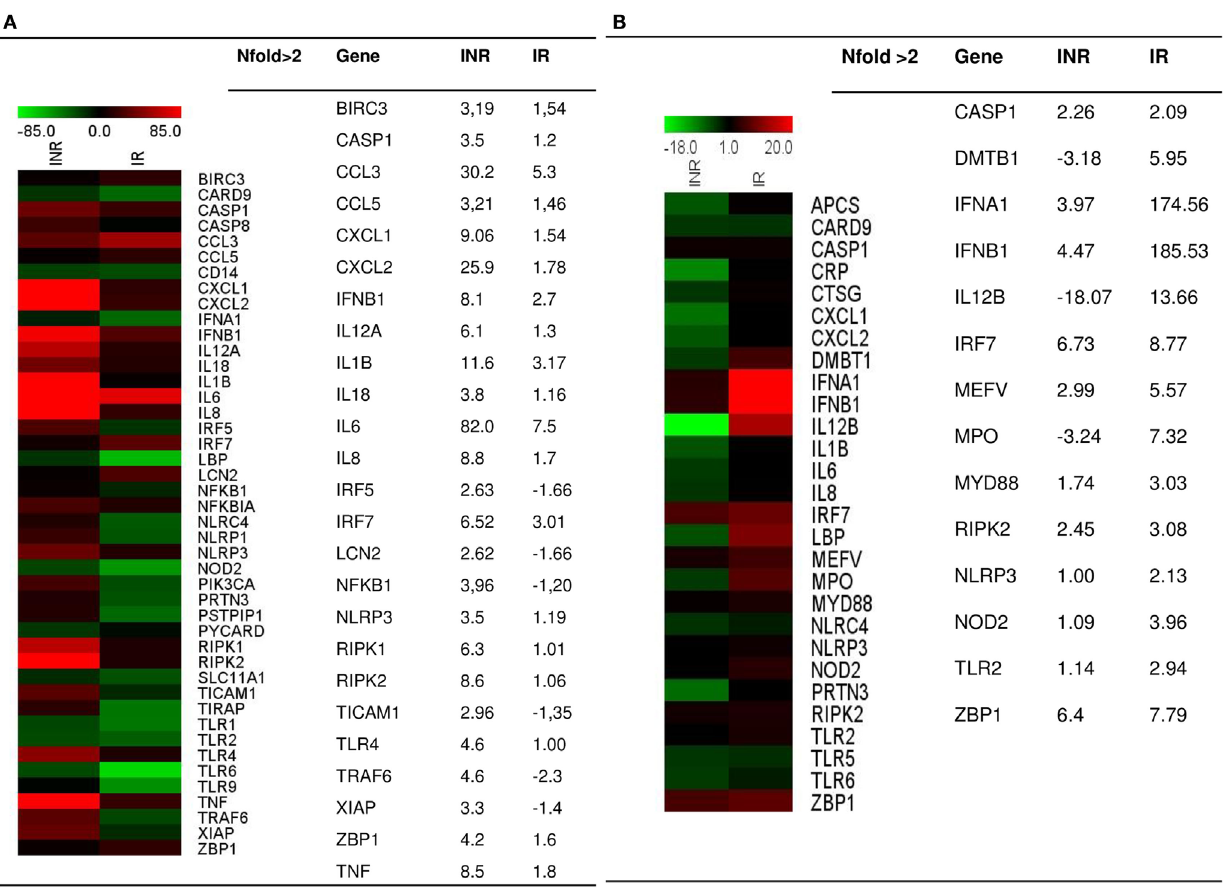
FigUre 1 | Inflammasome pathway. Real-time PCR Array on LPS- or AT2-treated-HIV-1 BaL -stimulated peripheral blood mononuclear cells (PBMCs) in INR and IR HIV-infected patients. Samples were pooled into two distinct groups (IRs and INRs) and experiment was done in triplicate. Gene expression ( n fold) is shown as a color scale from green to red (MEV multiple experiment viewer software). (a) N fold LPS-stimulated PBMCs vs unstimulated PBMCs; (B) N fold AT2-treated-HIV-1 BaL PBMCs vs unstimulated PBMCs. Only targets showing at least > 2-fold modulation are shown in